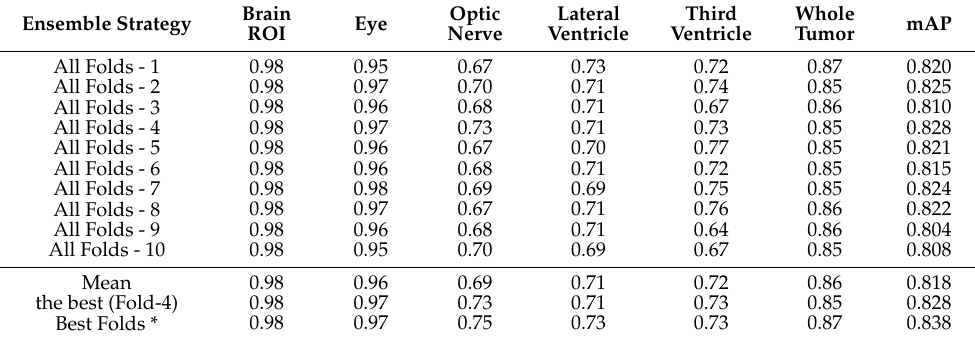
Table 6. Ensemble Strategy 3 and 4 results for different models fold-by-fold. Brain Ensemble Strategy ROI